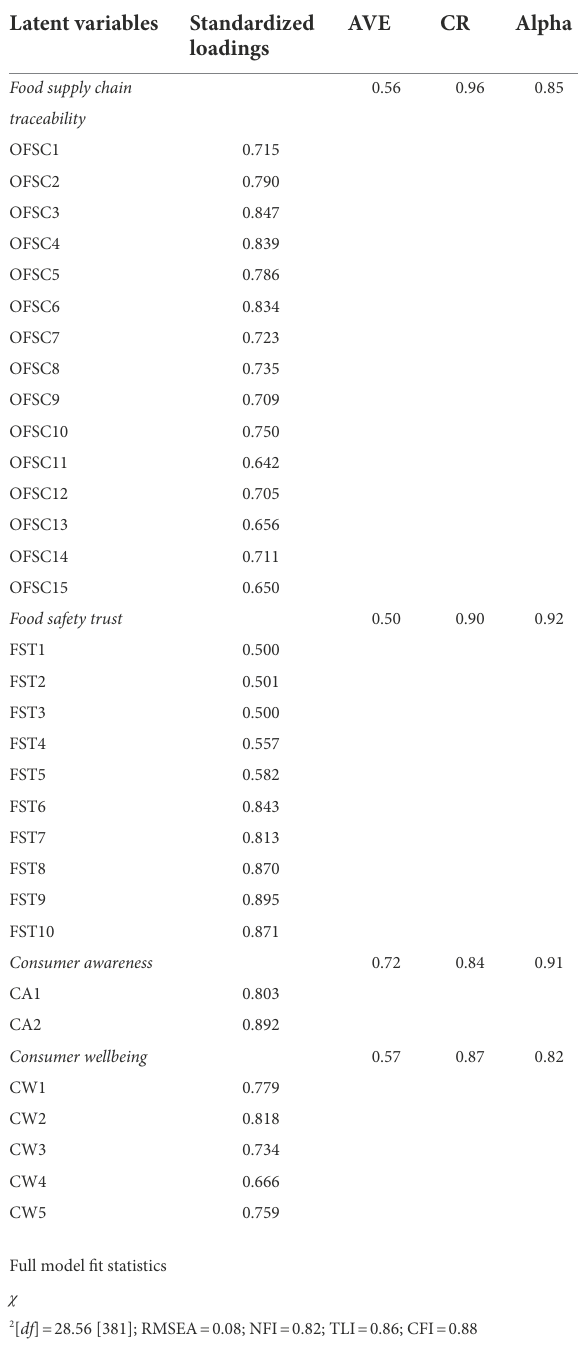
TABLE 1 Confirmatory factor analysis: Validity and